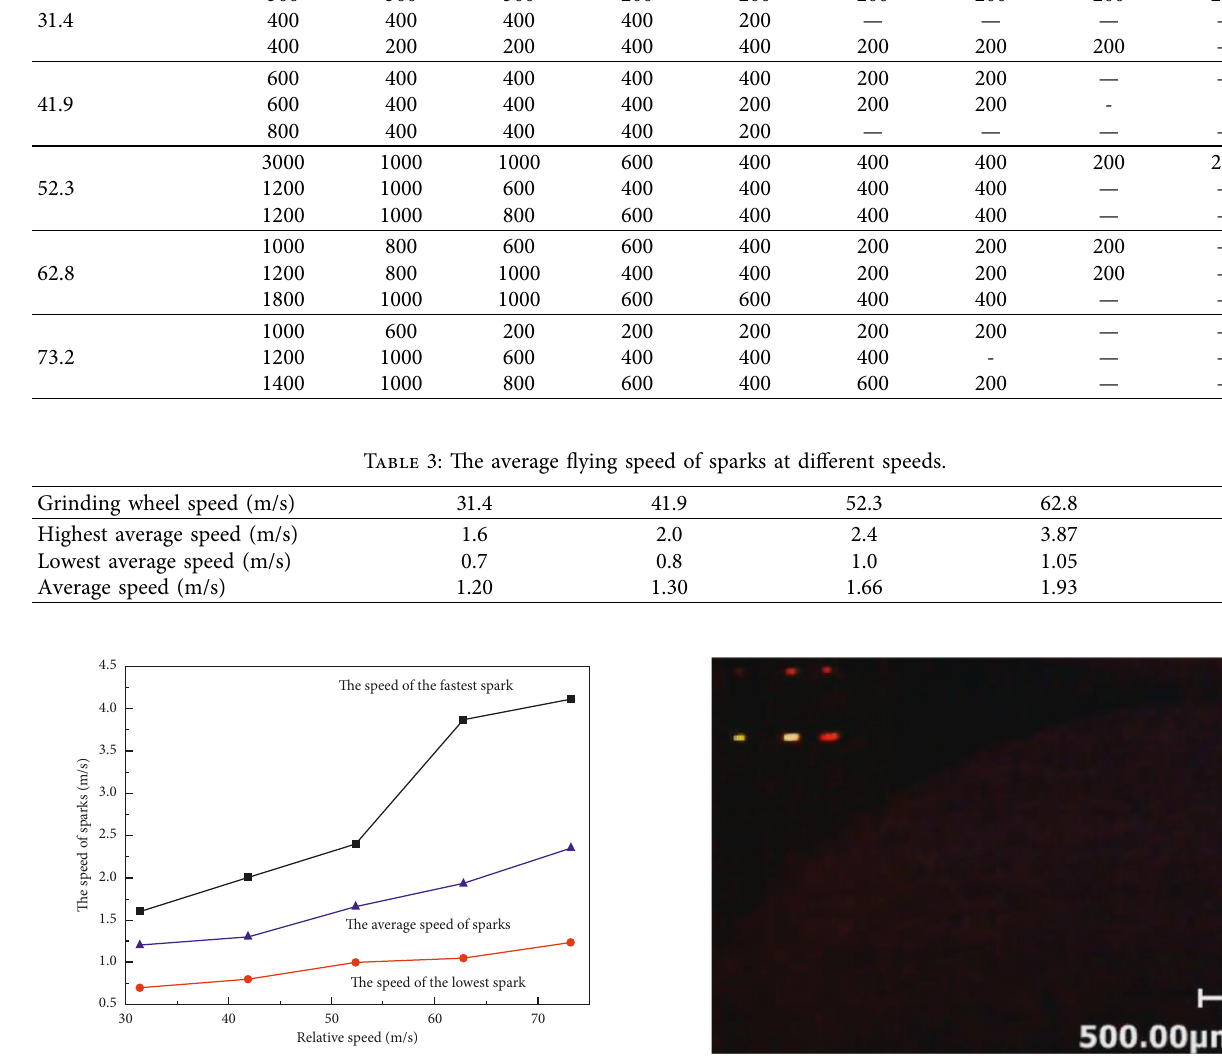
Figure 8: Relationship between spark velocity and relative friction speed.